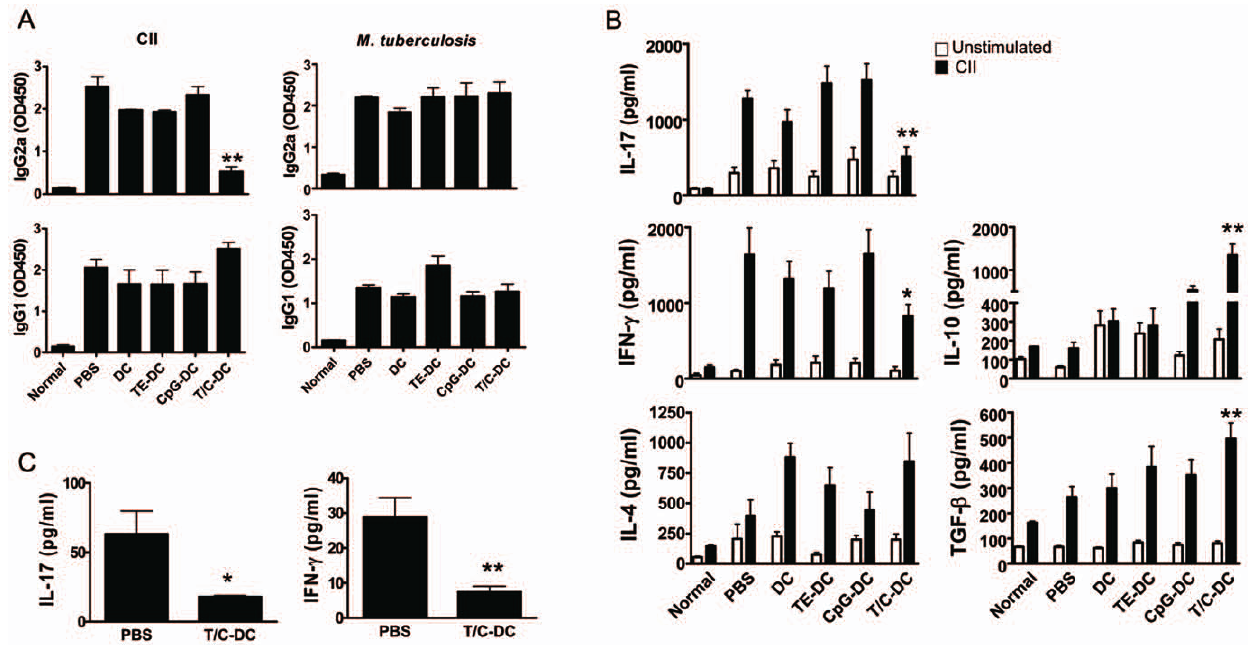
Figure 3. Decreased inflammatory responses after treatment with CII pulsed T/C-DC in CIA mice. A) IgG2a and IgG1 production against CII and Mycobateria tuberculosis were measured by ELISA in the sera from differentially treated DC recipient mice on day 35 of onset. Data are representative of two independent experiments. Values show the mean 6 SD of optical density at 450 nm (OD450) of 5 mice per group. B) IL-17, IFN- c , IL-4, IL-10 and TGF- b levels were detected by ELISA in the supernatant of cultures of DLN cells from mice on day 10 of onset stimulated with or without CII for 48 h. C) IL-17 and IFN- c were measured by ELISA in joint homogenate. Data are representative of three independent experiments. Values are the mean 6 SD. * P , 0.05, ** P , 0.005 versus PBS group in A, B and